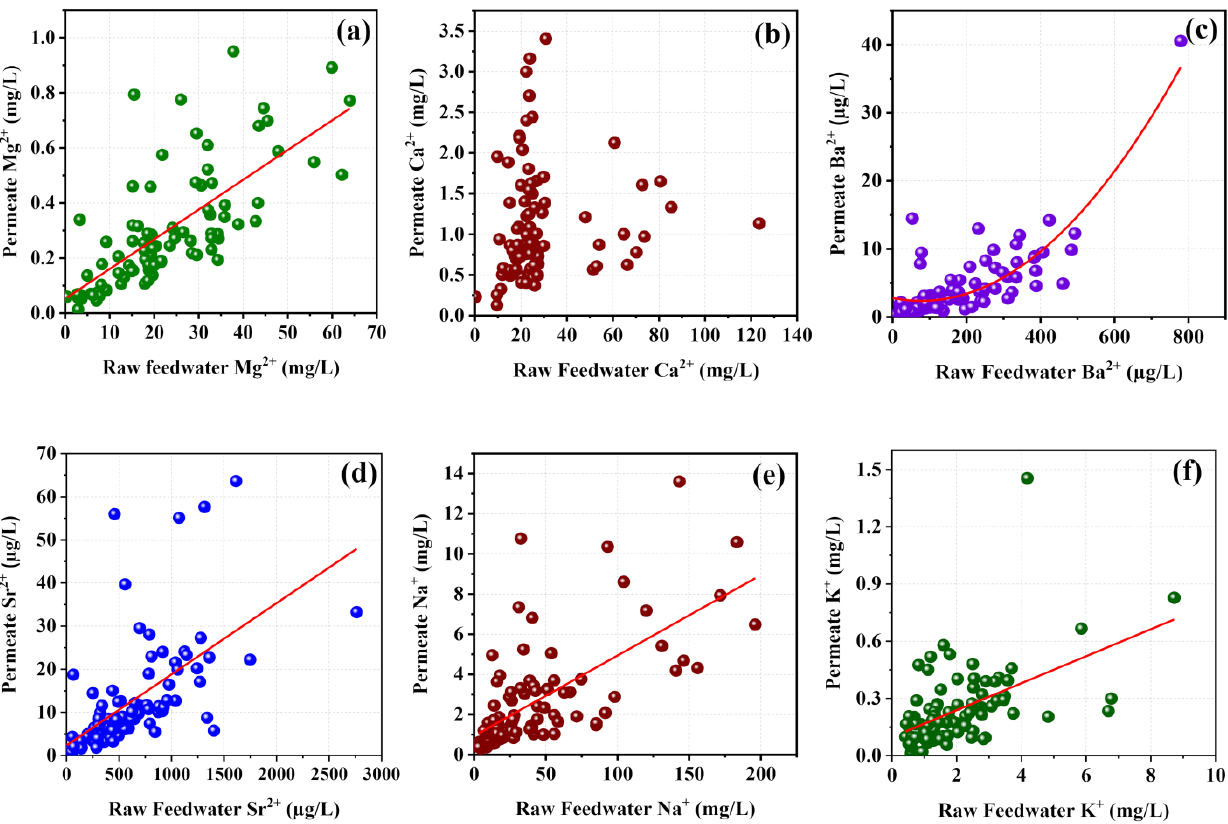
Figure 8. Major cation concentrations in the permeate with their feedwater cation concentrations, ( a ) variation of Mg 2+ in the permeate with Mg 2+ in the feedwater, ( b ) variation of Ca 2+ in the permeate with Ca 2+ in the feedwater, ( c ) variation of Ba 2+ in the permeate with Ba 2+ in the feedwater, ( d ) variation of Sr 2+ in the permeate with Sr 2+ in the feedwater, ( e ) variation of Na + in the permeate with Na + in the feedwater, and (f) variation of K + in the permeate with K + in the feedwater.